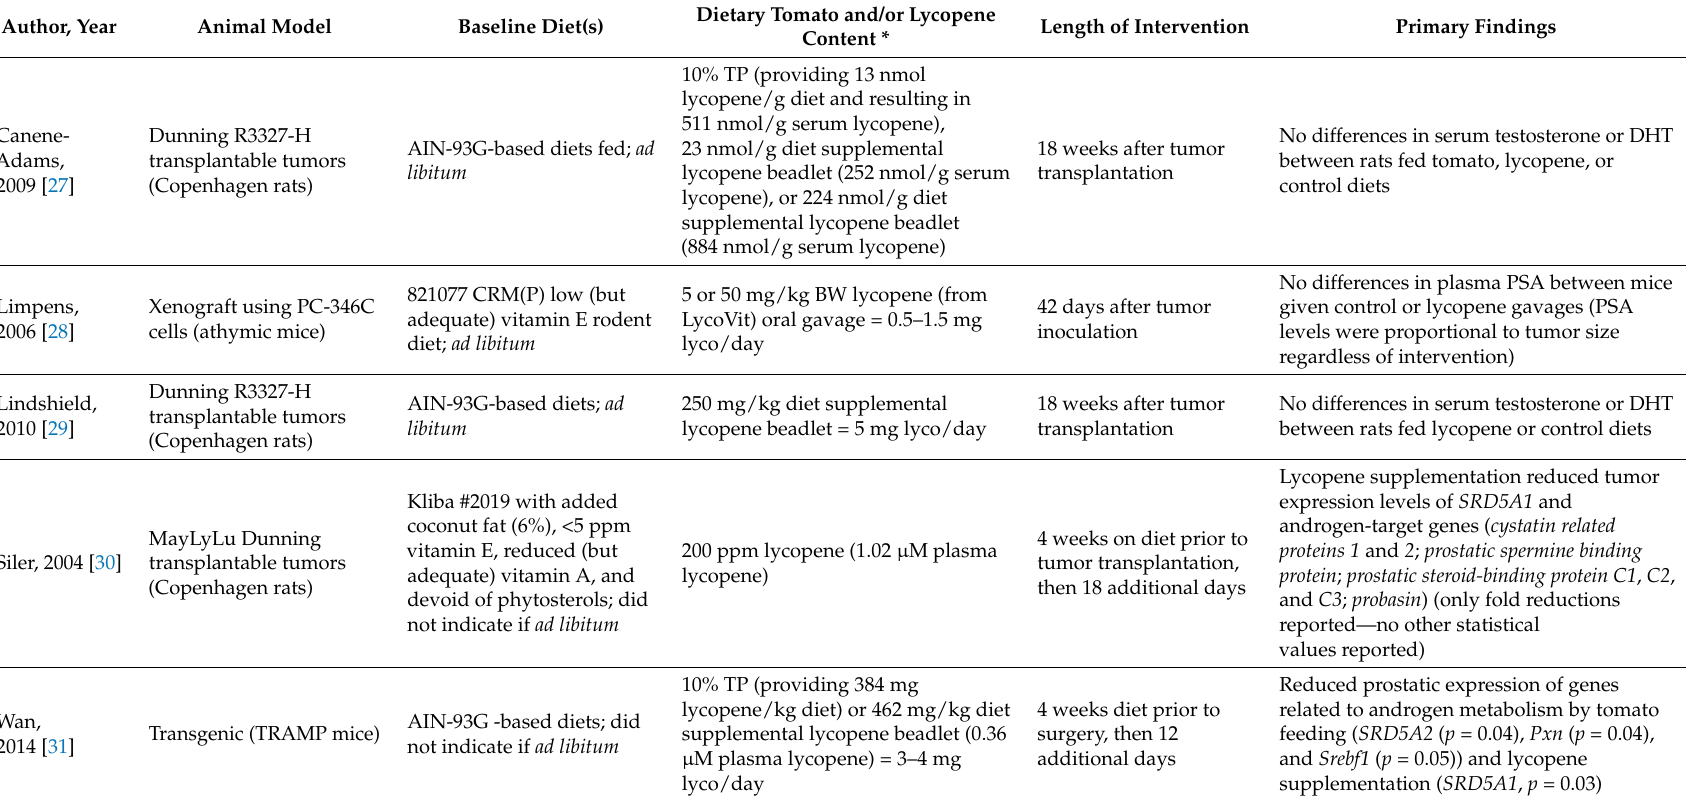
Table 1. Characteristics of included animal